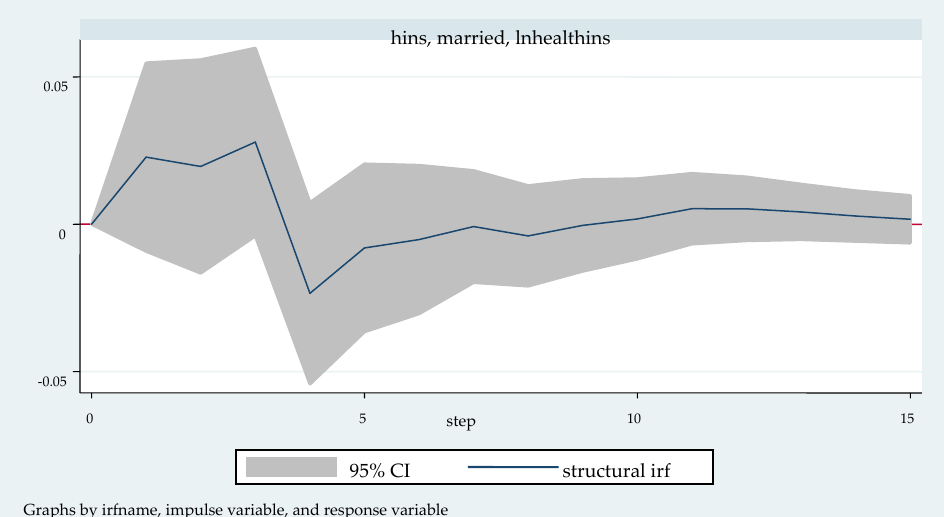
Figure 7. Impulse response function diagram of “lnhealthins” impacted by